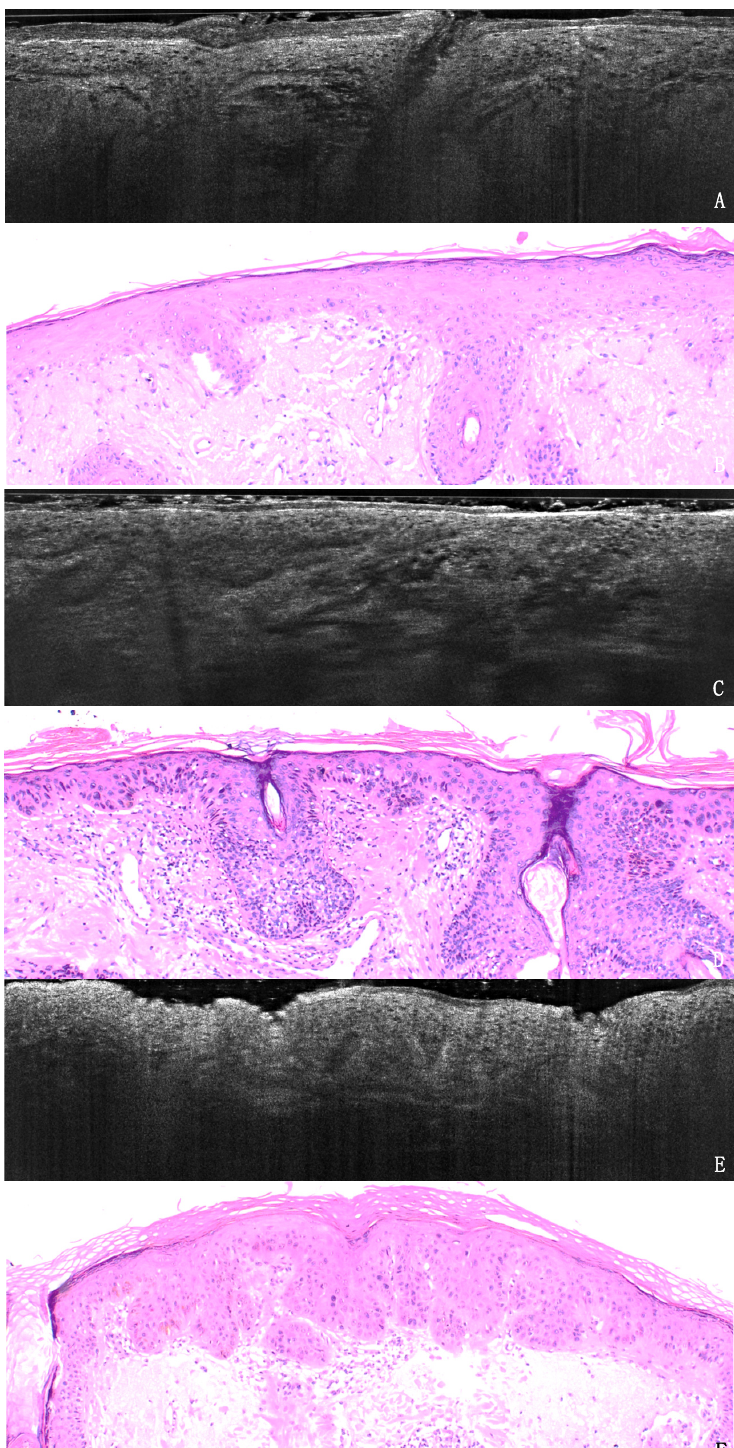
Figure 1. Example of three AK lesions in LC-OCT ( A , C , E ) and histology ( B , D , F ) in H&E sections, original magnification 40×. ( A , B ). AK PRO I shows basal crowding of keratinocytes in an otherwise regularly layered epidermis, with no protrusions into the dermis. ( C , D ). AK PRO II displays spikes of atypical keratinocytes slightly protruding into the papillary dermis. ( E , F ). AK PRO III shows the extended downward growth of atypical keratinocytes with spikes thicker than the overlying epi- dermis.